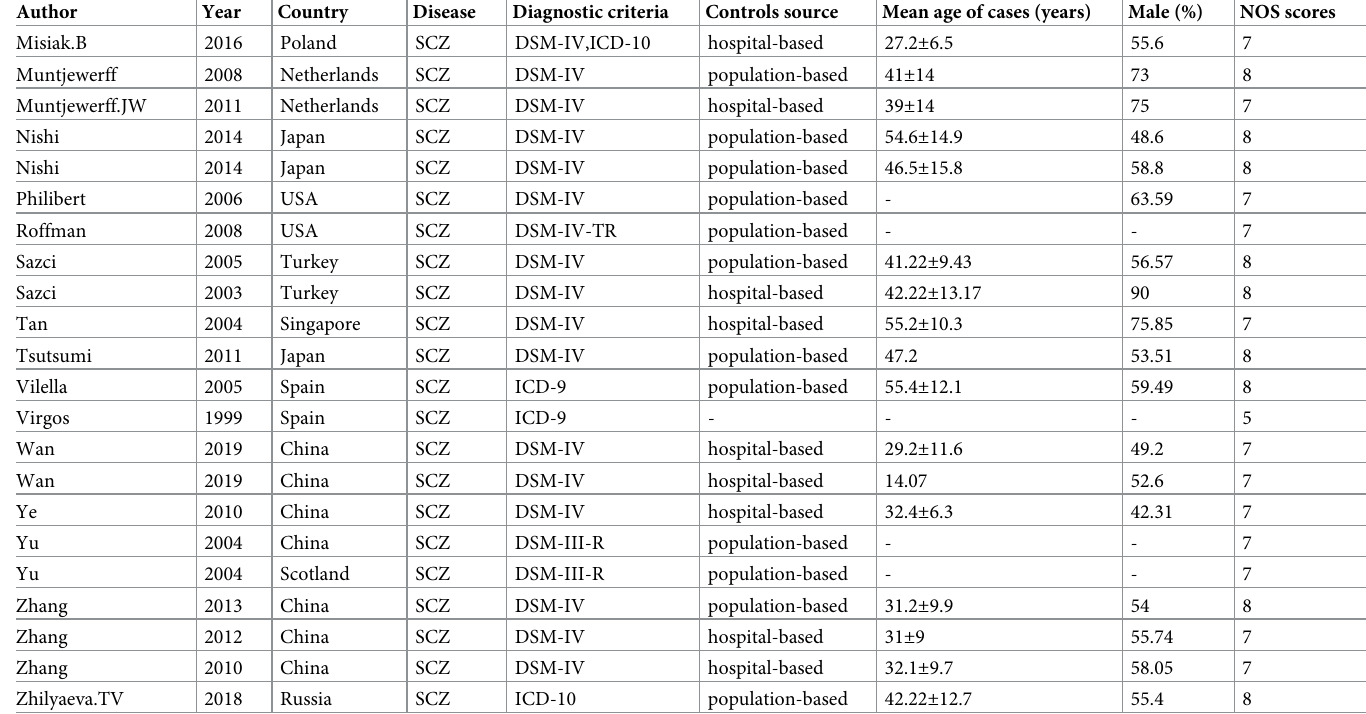
study was of low quality. Genotype and allele frequencies, HWE and sample size are given in Tables 2–4, respectively. Of the total of 67 studies, four showed significant deviations from HWE ( p < 0.05).